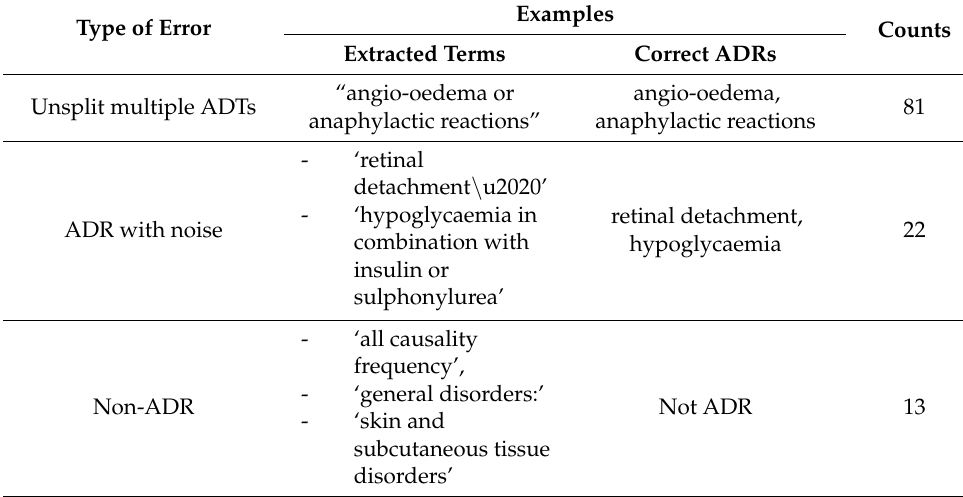
Table 4. Error analysis for false